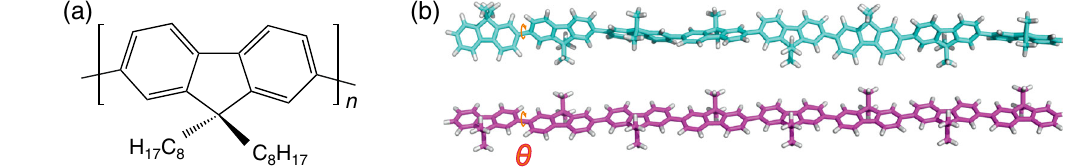
FIG. 1. (a) The chemical structure of PFO. Each of the di- n -octyl side chains attached to the central carbon atom (C 9 ) of a monomer is abbreviated as C 8 H 17 . (b) Molecular geometries of an oligofluorene (side chains represented by methyl groups for clarity) in the minimum potential energy, glassy conformation with dihedral angles θ of about 45 ° or 135 ° (top, cyan) and in the β -phase conformation, with θ ≈ 180 ° (bottom,